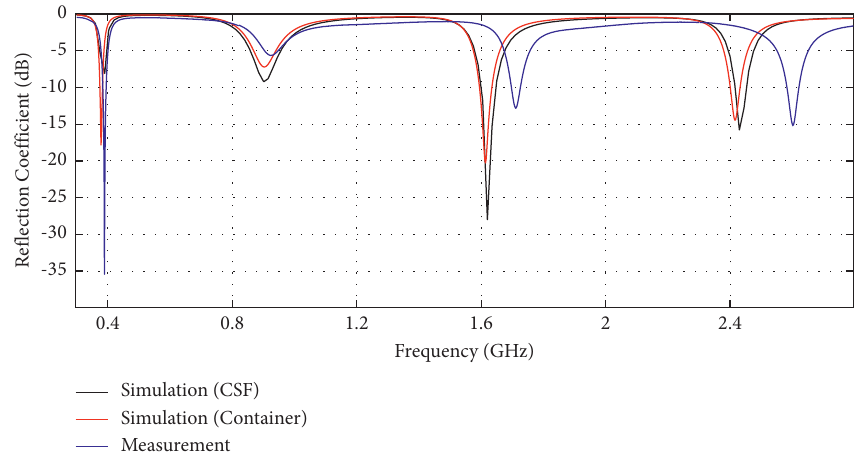
Figure 8: Comparison of the simulated and measured reflection coefficient (S